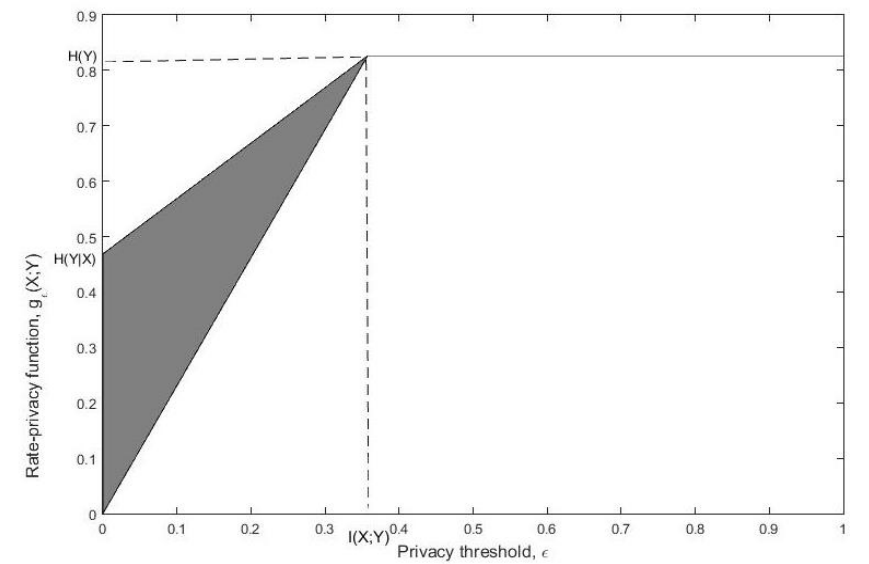
Figure 3. The region of g ε ( X ; Y ) in terms of ε specified by